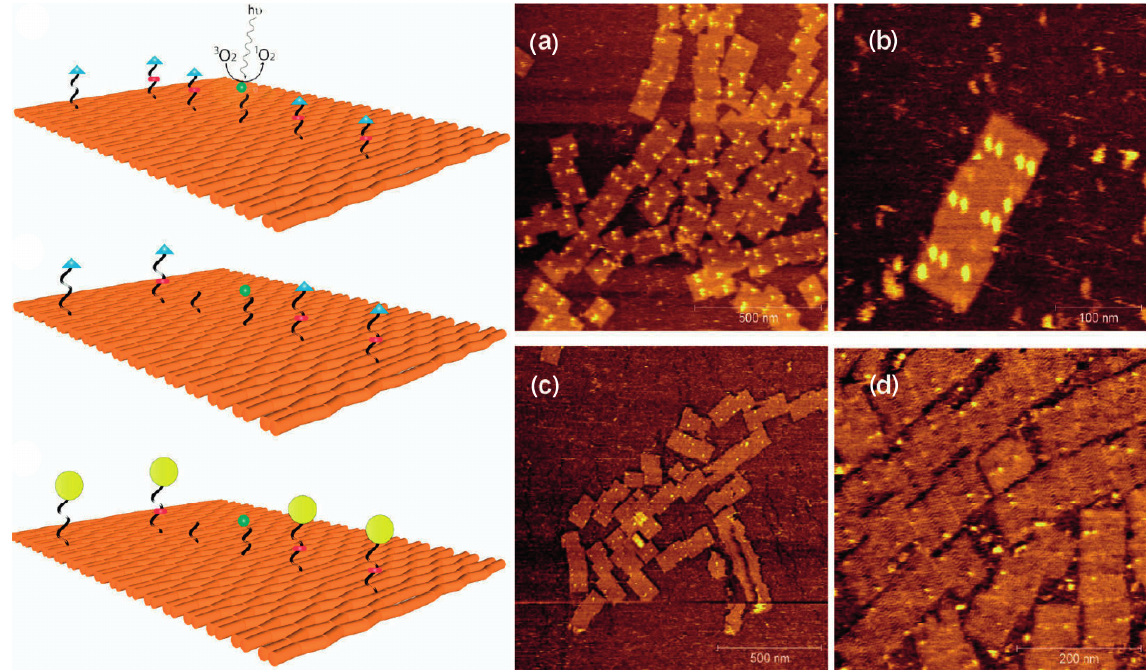
Figure 4. Left: Schematic presentation of the rectangular DNA origami platform used to study singlet oxygen production, diffusion and bond cleavage. Singlet oxygen is produced by an IPS photosensitizer in the center and induces bond cleavage in the SOC linkers placed at different distance from the IPS. After UV-irradiation and thus reaction with singlet oxygen SAv is added, which binds to the remaining strands to visualize them for AFM analyses. On the right examples of AFM images are shown. ( a ) Non-irradiated DNA origami platforms with the SOC linkers and one marker in the corner of the rectangle. A zoom-in is shown in ( b ). UV irradiation results in singlet oxygen production and cleavage of the SOC linkers, which is shown in ( c , d ). Adapted with permission from Ref. [25]. Copyright 2010 American Chemical